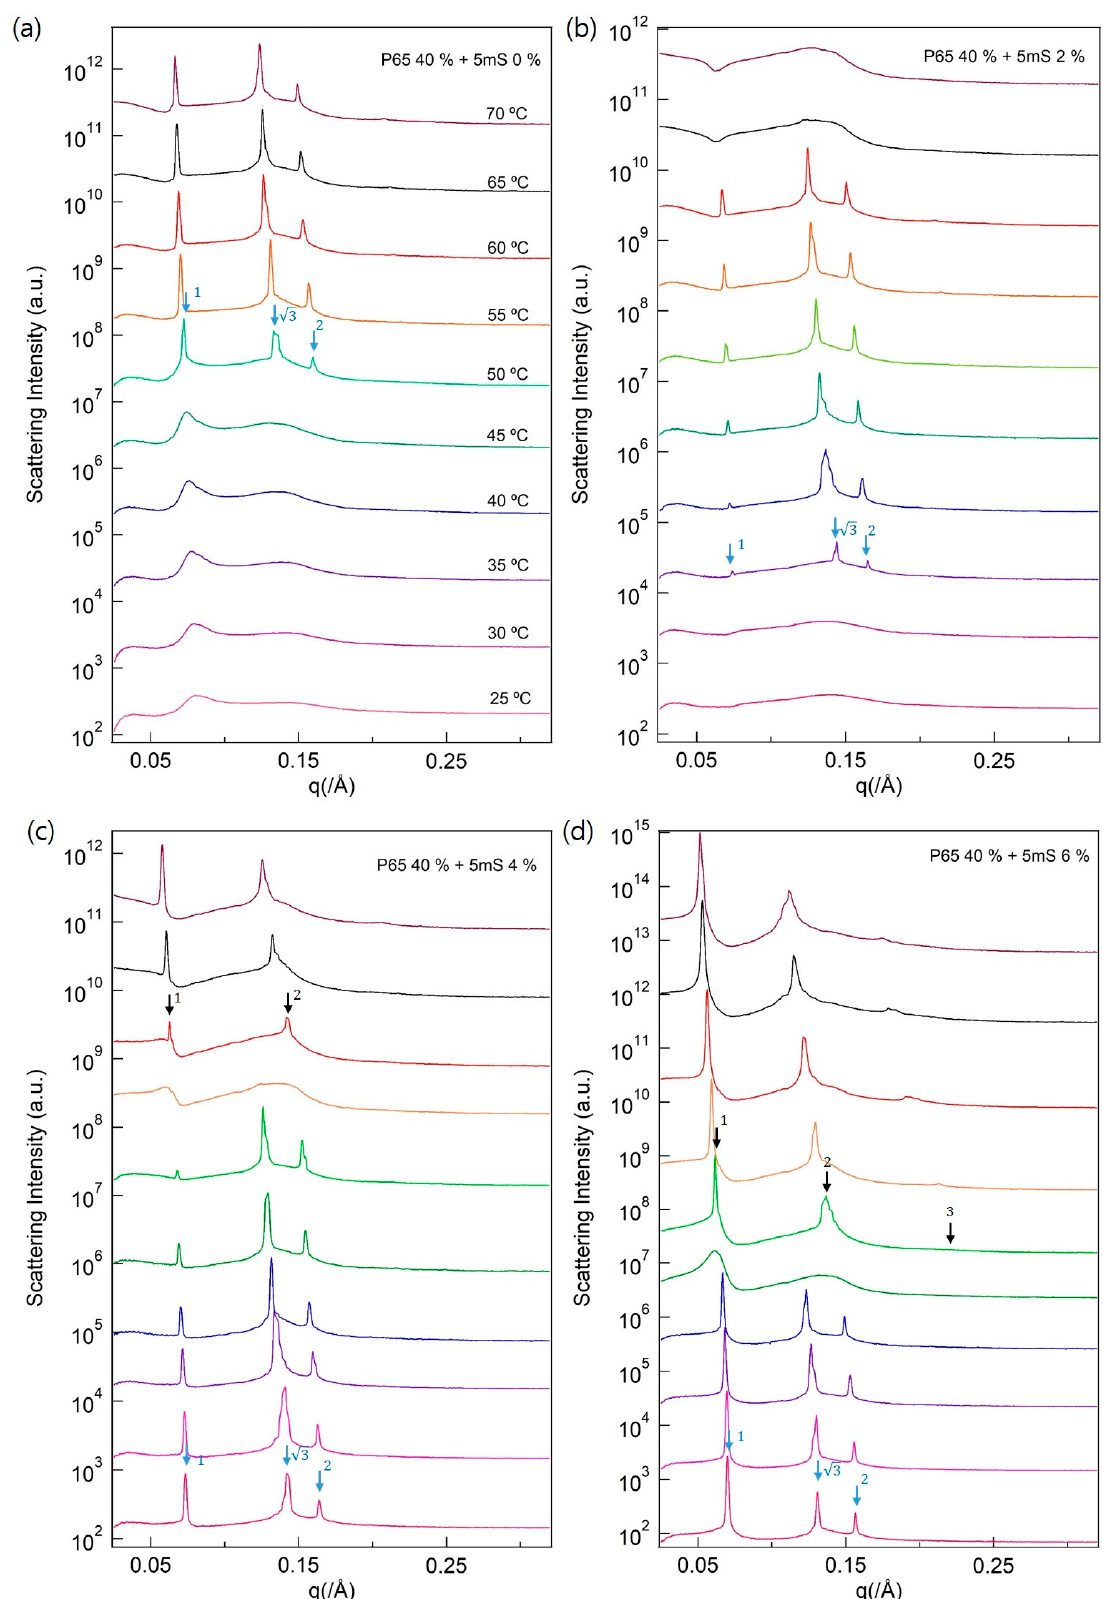
Figure 4. SAXS intensities of the P65-5mS complex in aqueous solution. ( a ) P65 35%-5mS 0.0 %, ( b ) P65 35%-5mS 2.0 %, ( c ) P65 35%-5mS 4.0 %, and ( d ) P65 35%-5mS 6.0 % were conducted depending on a various temperature. The red, light blue, and black arrows indicate the SAXS signals of the FCC, hexagonal, and lamellar phases, respectively.